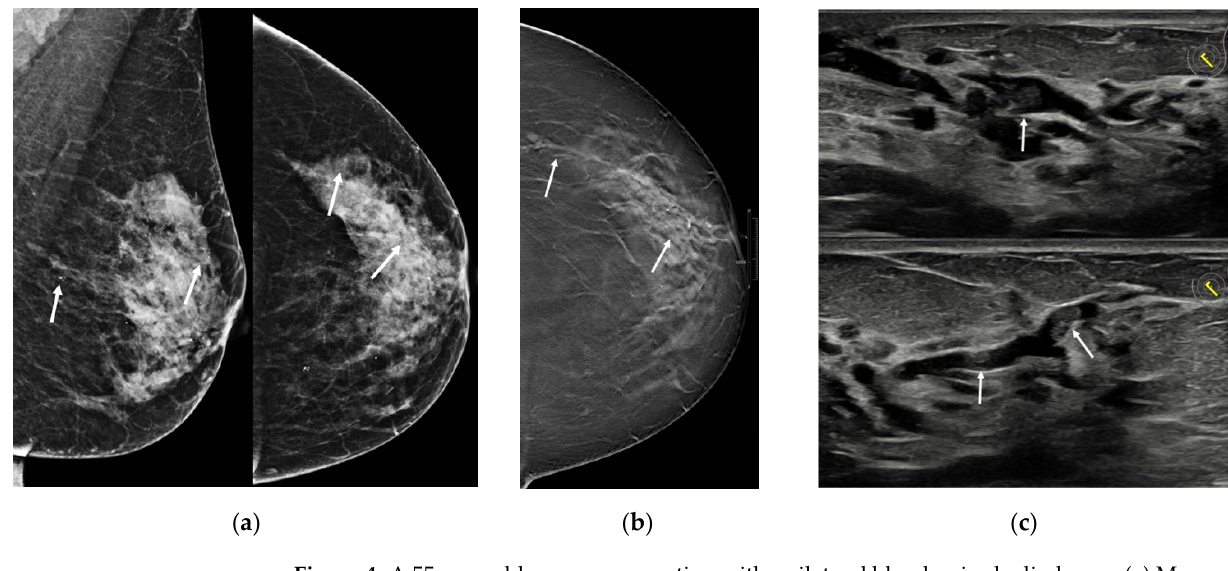
Figure 4. A 55-year-old woman presenting with unilateral bloody nipple discharge. ( a ) Mammography in medio-lateral view and cranio-caudal view showed multiple scattered calcifications (arrows). ( b ) Tomosynthesis slice in the CC view showed multiple dilated ducts from the retroareolar region to the outer quadrants (arrows). ( c ) Ultrasound demonstrated multiple dilated ducts partially filled with intraluminal content